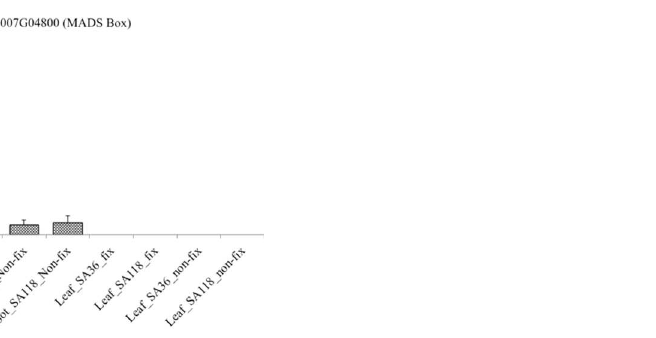
Fig 5. Relative expressionof Phvul . 007G048000 (MADS BOX transcription factor) in leaves, roots and nodules of SA36 and SA118 grown under nitrogen fixing and non-fixing condition. Relativegene expressionis presentedusing read count. Read count is number of reads (averageof three replications) alignedto the gene after normalizing for total number of reads mapped for each library using HTSeq.